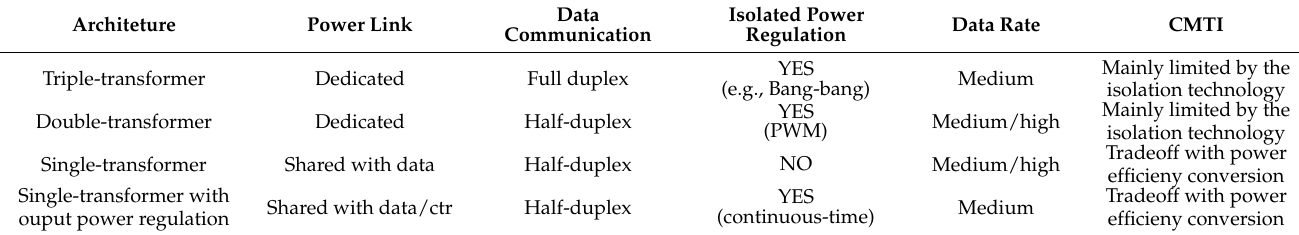
Tradeoff with power efficieny conversion